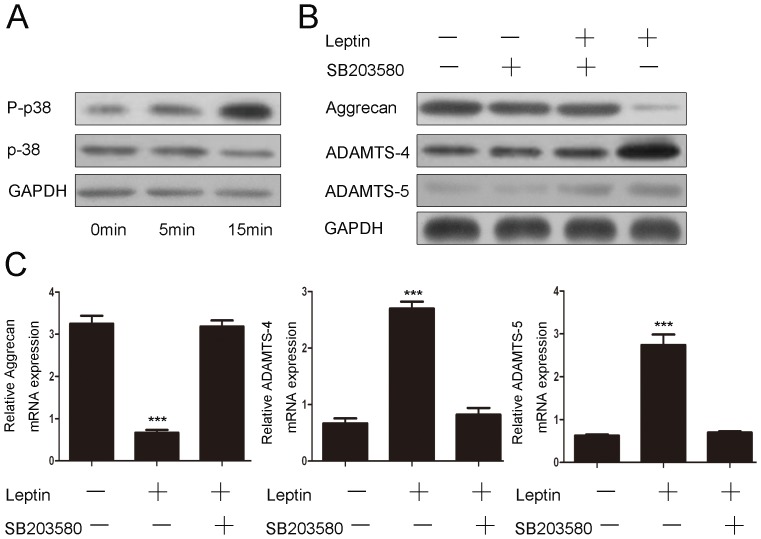
Pharmacological inhibition of p38 MAPK pathways prevented the regulation of aggrecan, ADAMTS-4 and ADAMTS-5 by leptin.(A) The protein amouts of phosphorylated forms of p38 (P- p38 were detected with western blotting analysis. GAPDH was also detected for a loading control. (B) NP cells were treated with vehicle (contorl) (-), 10 ng/ml leptin (+), 10 µM SB203580 for 48 h. The amouts of aggrecan, ADAMTS-4 and ADAMTS-5 protein were detected with western blotting analysis using GAPDH as an internal control. (C) Aggrecan, ADAMTS-4 and ADAMTS-5 mRNA expression were detected with Real-time RT-PCR analysis using GAPDH as an internal control. Error bars represent standard deviration. The medium was changed every day.***p<0.001.